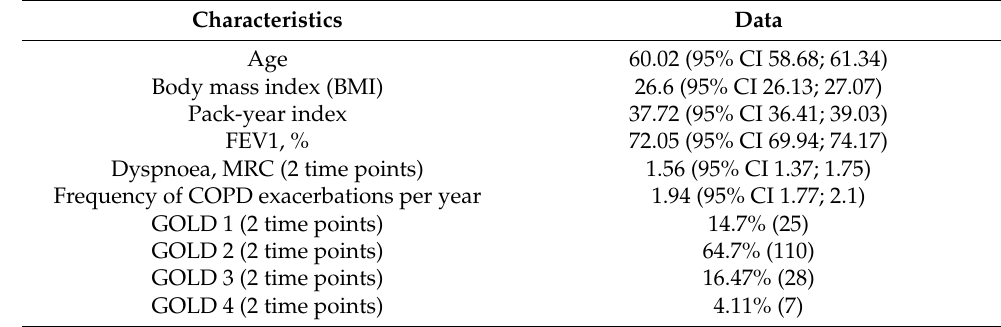
Table 1. Clinical characteristics of